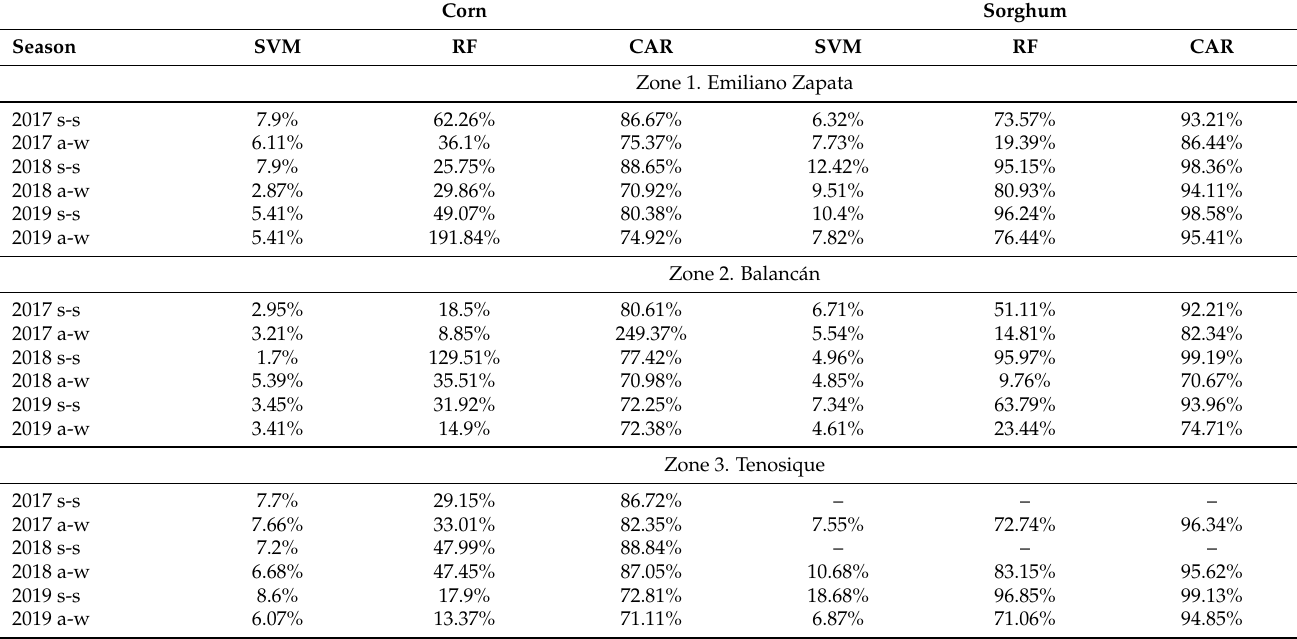
Table 10. Percentage of corn and sorghum crop error by each classification method.